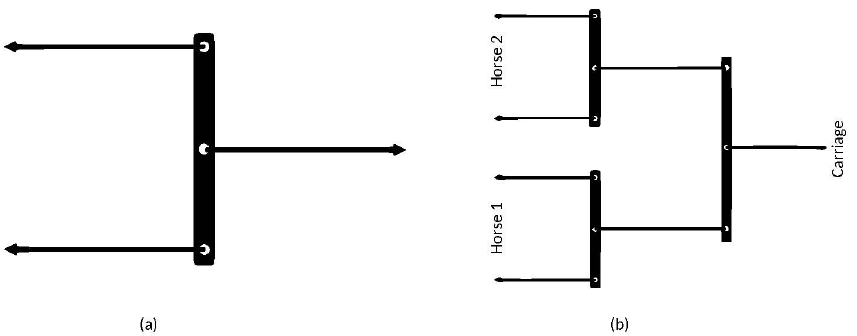
Figure 3. Whippletree mechanism: ( a ) basic element of whippletree mechanism and ( b ) a double-tree arrangement in a two-horse